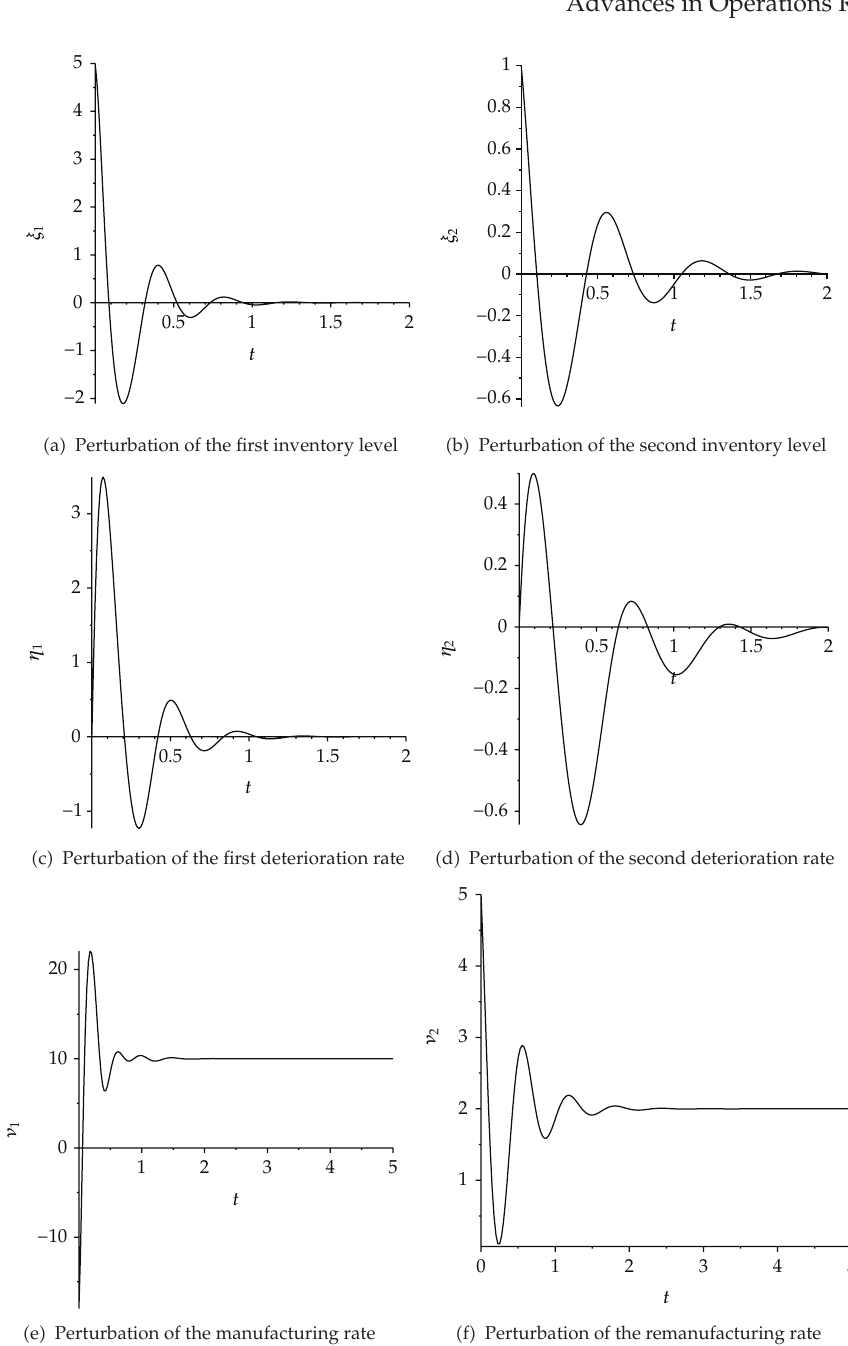
Figure 1: (cid:5) a (cid:6) : the perturbation of the first inventory level ξ 1 (cid:5) t (cid:6) , (cid:5) b (cid:6) : the perturbation of the second inventory level ξ 2 (cid:5) t (cid:6) , (cid:5) c (cid:6) : the perturbation of the first deterioration rate η 1 (cid:5) t (cid:6) , (cid:5) d (cid:6) : the perturbation of the second deterioration rate η 2 (cid:5) t (cid:6) , (cid:5) e (cid:6) : the perturbation of the manufacturing rate ν 1 (cid:5) t (cid:6) , and (cid:5) f (cid:6) : the perturbation of the remanufacturing rate ν 2 (cid:5) t (cid:6) , with the initial perturbations: ξ 1 (cid:5) 0 (cid:6) (cid:7) 5, ξ 2 (cid:5) 0 (cid:6) (cid:7) 1; η 1 (cid:5) 0 (cid:6) (cid:7) 0 . 02, η 2 (cid:5) 0 (cid:6) (cid:7) 0 . 02; ν (cid:5) 0 (cid:6) (cid:7) 5,